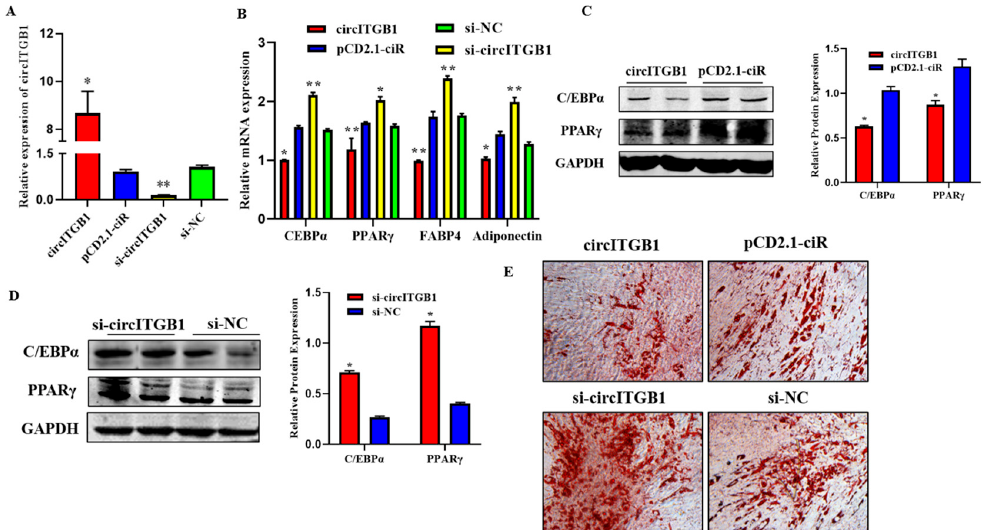
Figure 3. Effect of circITGB1 on adipocyte differentiation. ( A ) The quantitative PCR (qPCR) results show the expression level of circITGB1 after transfection of adipocytes with pCD2.1-circITGB1 and si-circITGB1. ( B ) The mRNA expression levels of C/EBPa, PPAR γ , FABP4, and adiponectin in adipocytes by qPCR. ( C , D ) The protein expression levels of PPAR γ and C/EBPa in adipocytes were indicated by Western blot. ( E ) Oil red O staining revealed that circITGB1 inhibited lipid droplet formation. * p < 0.05, ** p < 0.01.